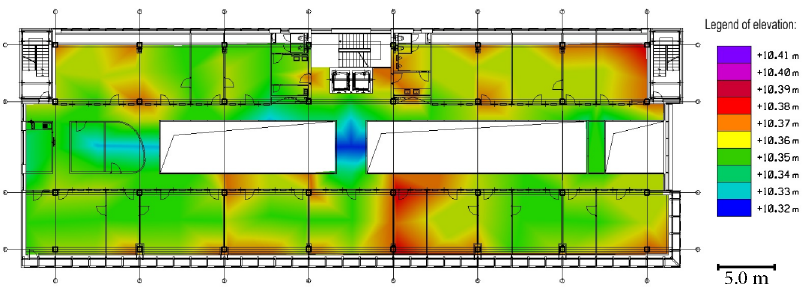
Figure 13. The colour hypsometry model of the 4 th AGL floor with the legend of height